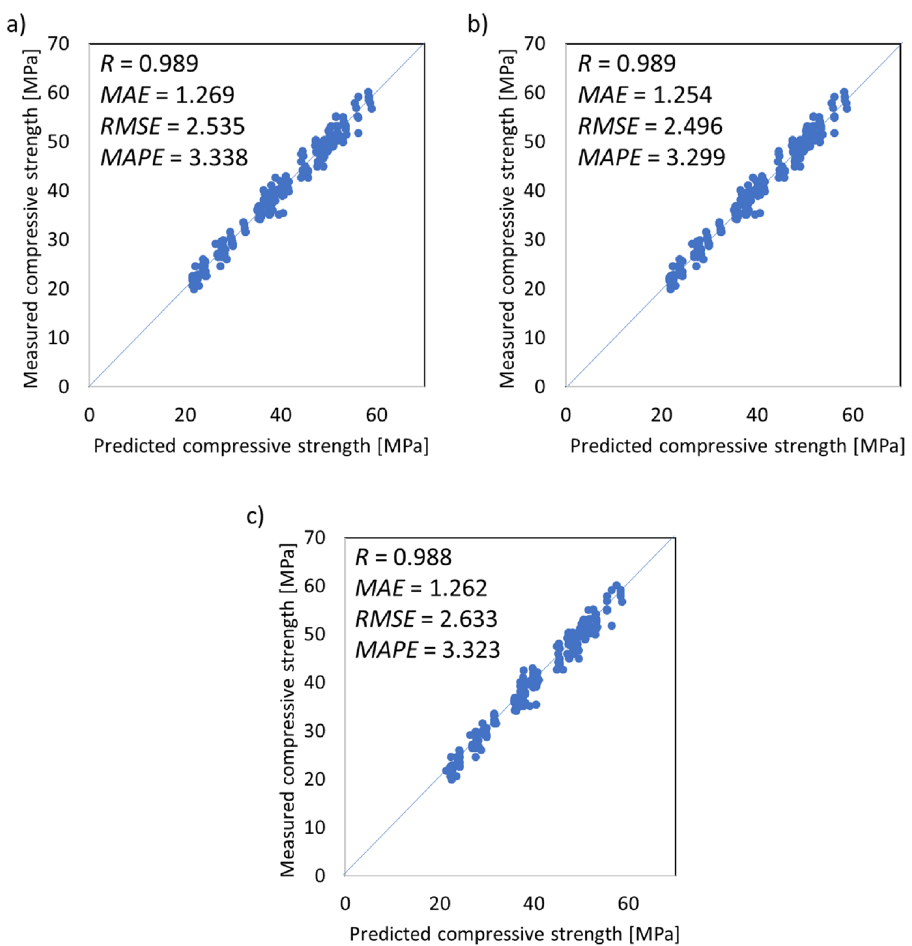
Figure 7. The relations between the measured compressive strength and predicted compressive strength by ( a ) decision tree, ( b ) random forest and ( c ) AdaBoost